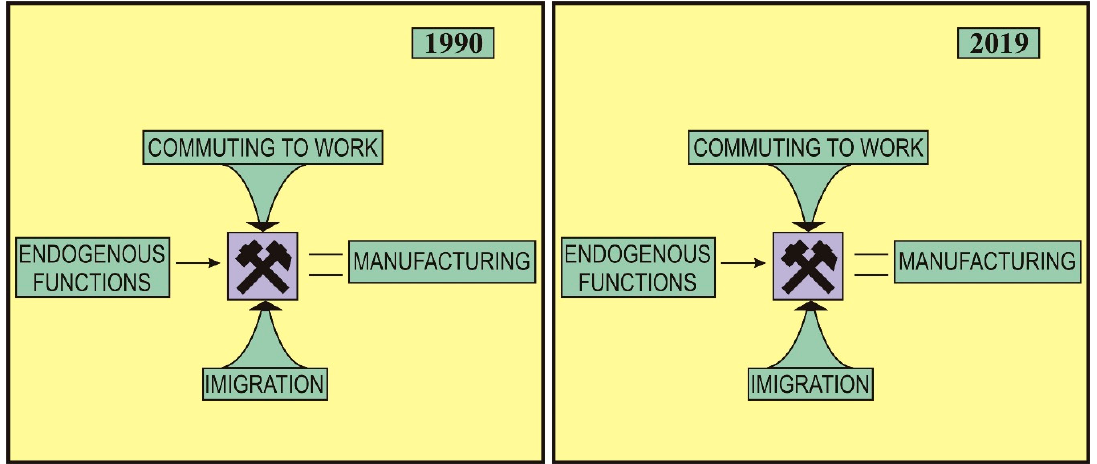
Figure 6. Socio-economic model of the development of a small mining town with continuing coal mining operations (illustration sourced by authors).